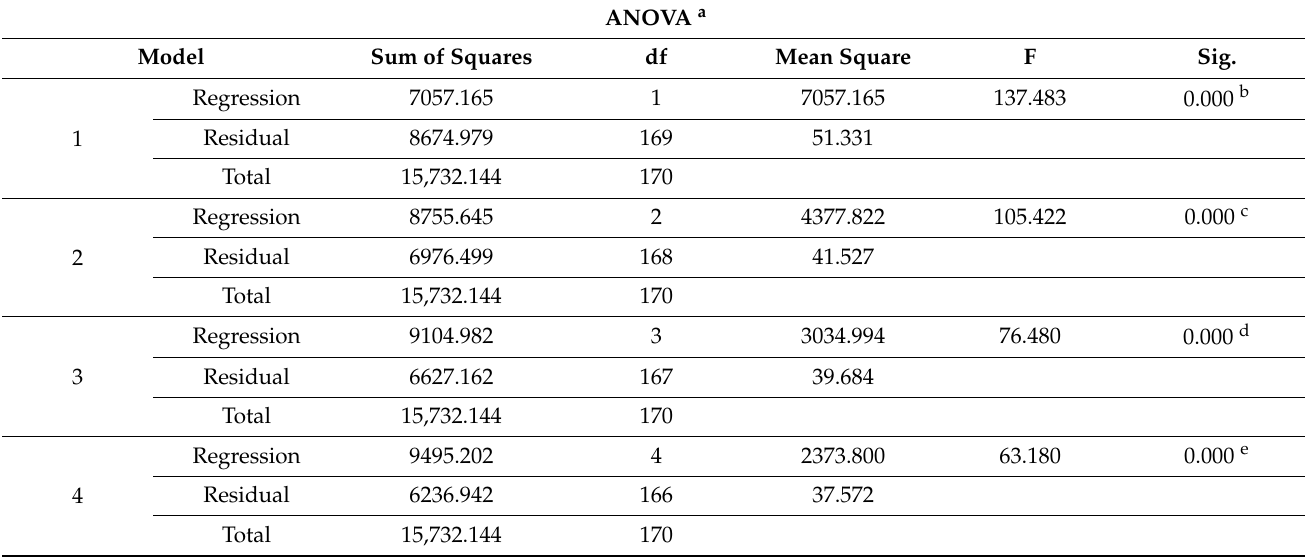
Table 6. ANOVA summary of the estimated regression model. ANOVA